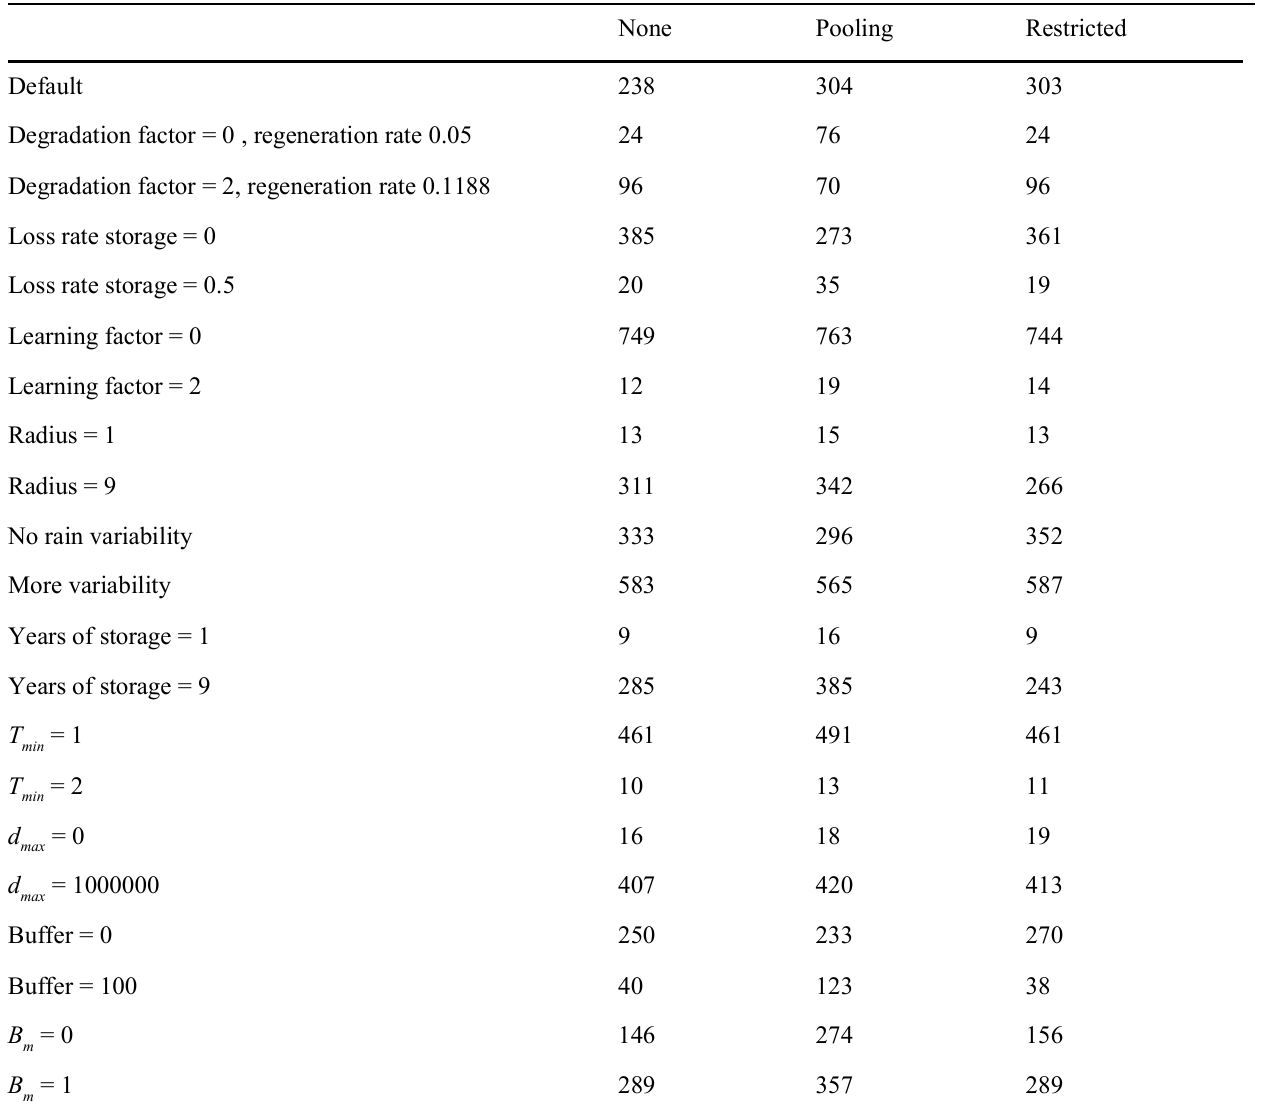
Table 4. The average population level over 10,000 time steps of 100 runs for various parameter combinations and assumptions. None Pooling